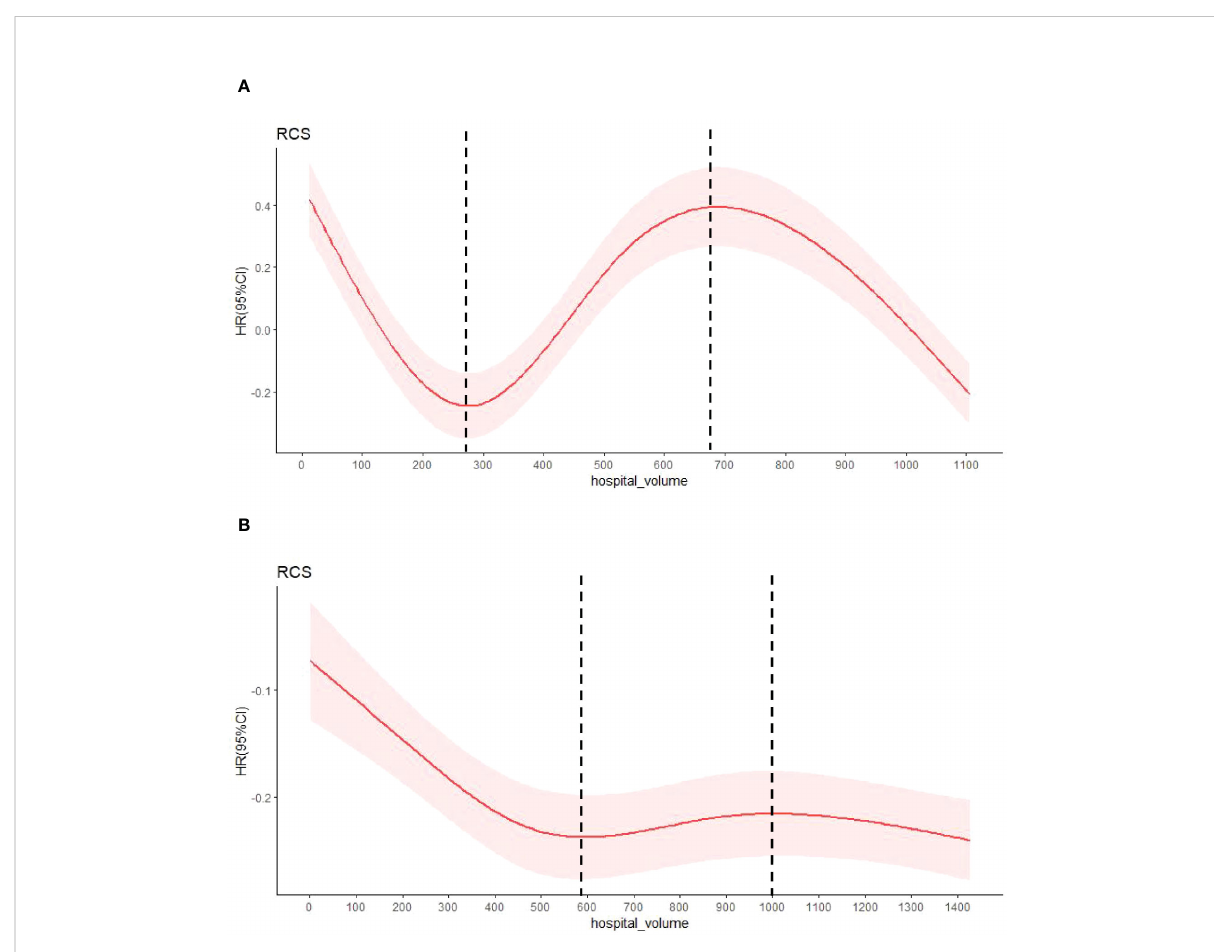
FIGURE 1 The HR by annual average hospital volume with restricted cubic spline fi t. (A) shows patients with esophageal cancer from 1973 to 1996, and (B) from 1997 to 2020.The relationship between known covariable-adjusted risk of death and annual hospital volume. The solid red line represents a restricted cubic spline (RCS) fi t and the light red shadow represents a 95% con fi dence interval for the RCS fi t. The vertical dashed lines are the extremes of the